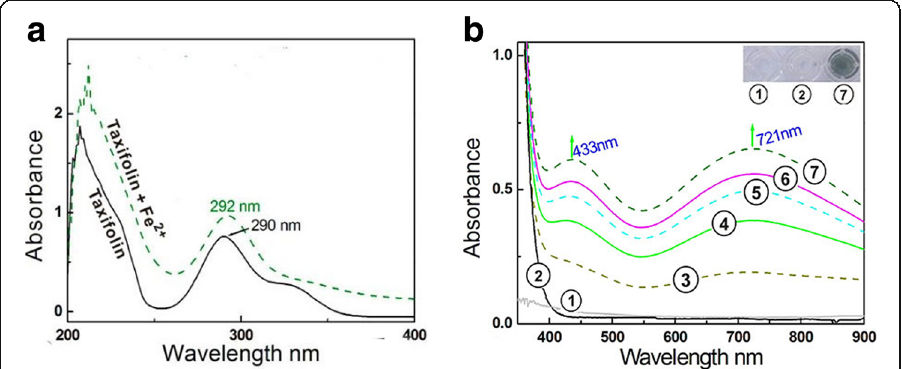
Fig. 3 The UV-vis spectra of (+) taxifolin and its Fe 2+ -complex. a Comparison of UV spectra of 0.05